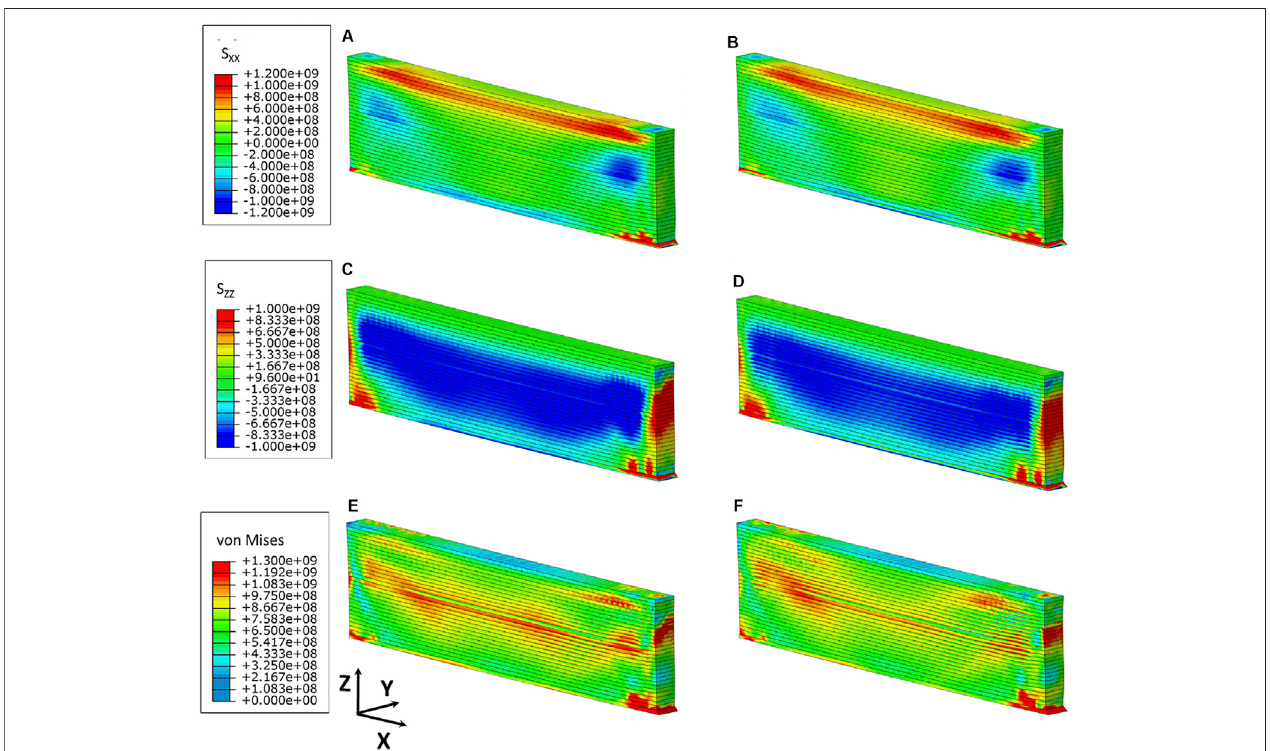
FIGURE 11 | Residual stress (Pa) comparison between the three laser powers for the transverse scanning patterns in Figure 1 . The residual stresses are shown along a centerline cross section of the part-scale simulations. Longitudinal stress (S xx ) for laser power (A) 180 W and (B) 220 W. Build direction stress (S zz ) for laser power (C) 180 W and (D) 220 W. Von Mises stress for laser power (E) 180 W and (F) 220